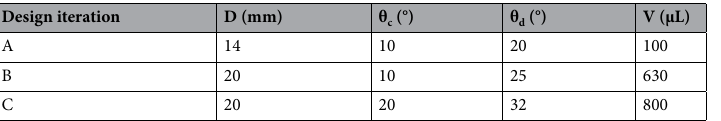
Table 1. Parameters of the designed collectors. Design diameter (D), collection angle (θ c ), drain angle (θ d ), and designed capacity volume (V) for each design